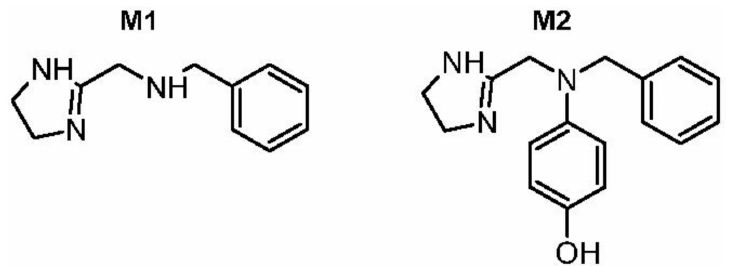
Figure4. ThestructuresofthetwomostabundantPhaseImetabolitesofANT: M1 and M2 . Thestructure of M2 was confirmed by chemical